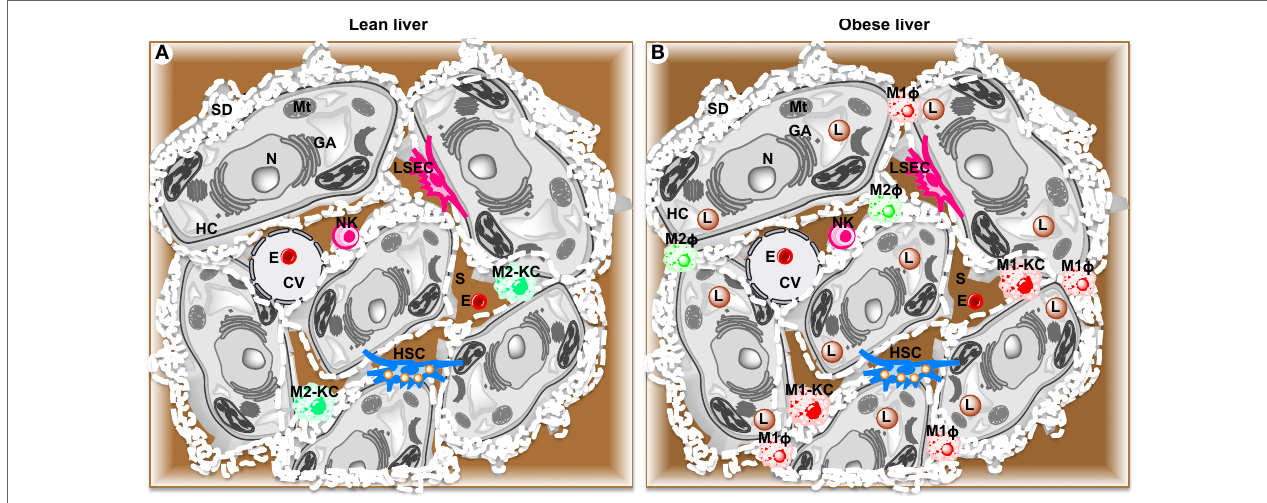
FigURe 1 | Schematic diagram showing parenchymal and non-parenchymal cells in liver . (A) Lean liver showing parenchymal hepatocytes (HC) and non-parenchymal anti-inflammatory Kupffer cells (M2-KC), natural killer cells (NK), hepatic stellate cells (HSC), and liver sinusoidal endothelial cells (LSEC). (B) High fat diet-induced obese liver showing activated pro-inflammatory Kupffer cells (M1-KC), recruited hepatic macrophages (RHM), and lipid droplets (L). CV, central vein; E, erythrocyte; GA, Golgi apparatus; Mt, mitochondria; N, nucleus; S,